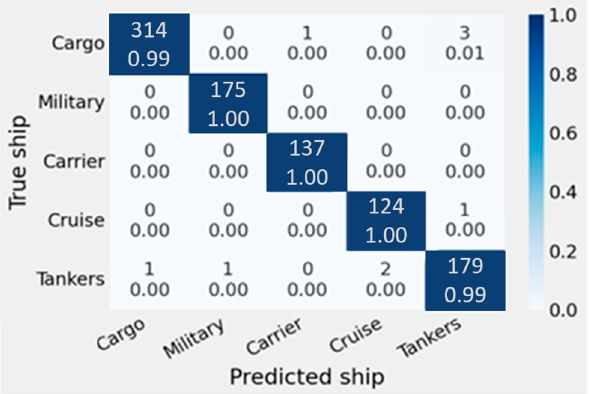
Figure 8. Confusion matrix for game ship classification dataset.